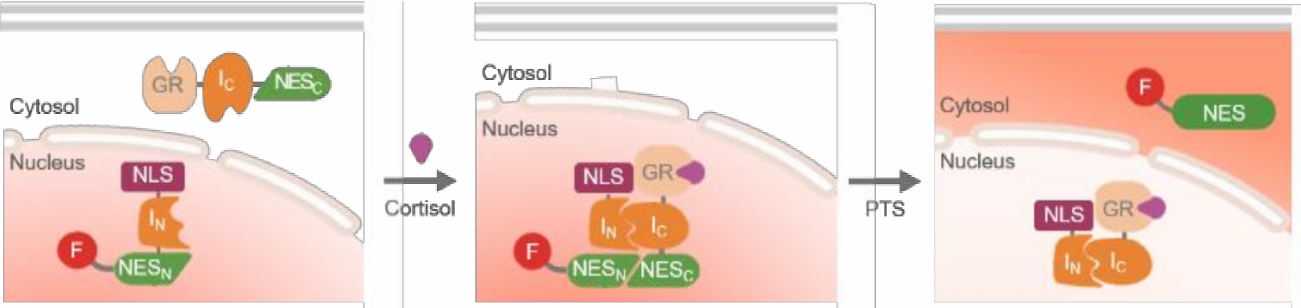
intein are initially located in two different compartments of a sensor cell to hinder the spontaneous protein trans-splicing. The target induces nuclear translocation of the glucocorticoid receptor (GR) containing fusion protein to initiate conditional protein splicing (CPS). The reconstituted signal peptide is instantly activated to deliver the fluorescent cargo into the cytosol to report the presence of the